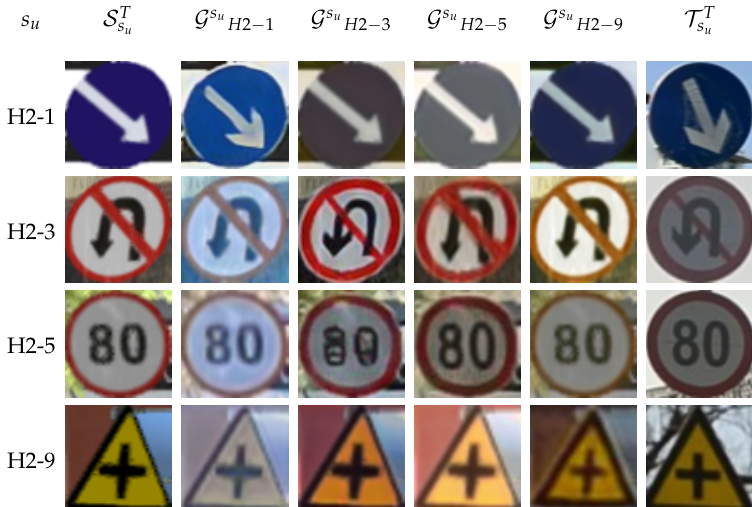
Figure 5. Samples based on H2-X splits (Figure 3). Rows: Splits with classes in the role of unknown. Left-to-right columns: Samples from SYNTHIA-TS, SYNTHIA-TS samples transformed by a CycleGAN trained on SYNTHIA-TS, and Tsinghua samples of classes in H2-1 split—which play the role of known classes here—, analogous for H2-3 instead of H2-1, for H2-5 and H2-9, and samples from Tsinghua.